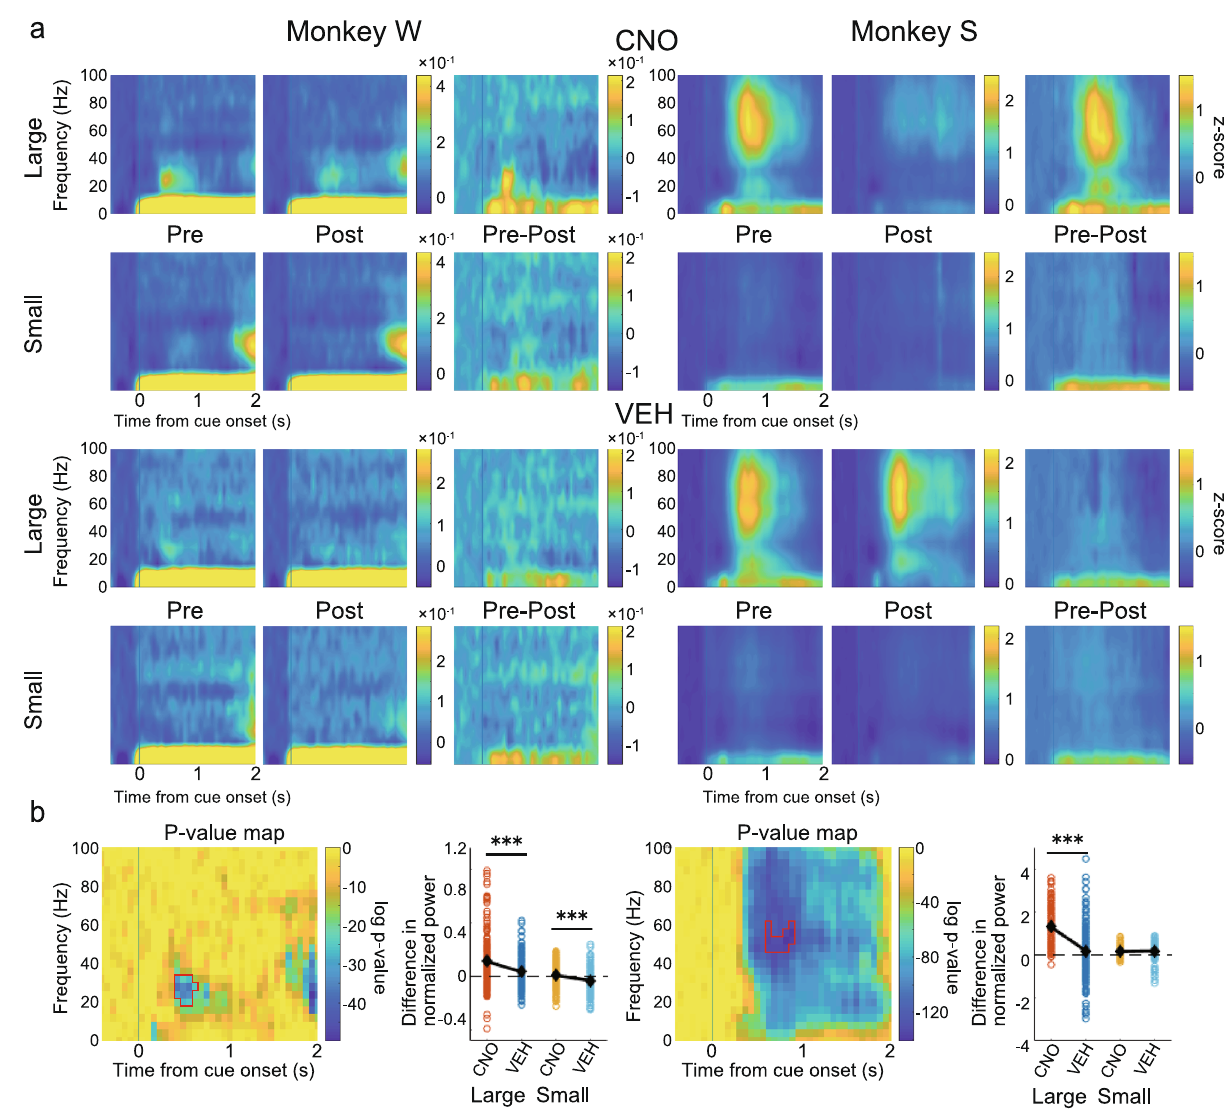
Fig. 5 Effects on spectrogram power in the CdN after cue onset. a Normalized and averaged spectrograms of LFPs from electrodes in the CdN for Monkey W (Left) and Monkey S (Right). All features in this panel are the same as in Fig. 4a. b For each monkey: left: p -value map to extract ROIs; right: comparison of effects of CNO/VEH administration (Pre – Post). All features in this panel are the same as in Fig. 4b. CdN caudate nucleus, CNO clozapine N-oxide, VEH vehicle, LFP local fi eld potential, ROI region of